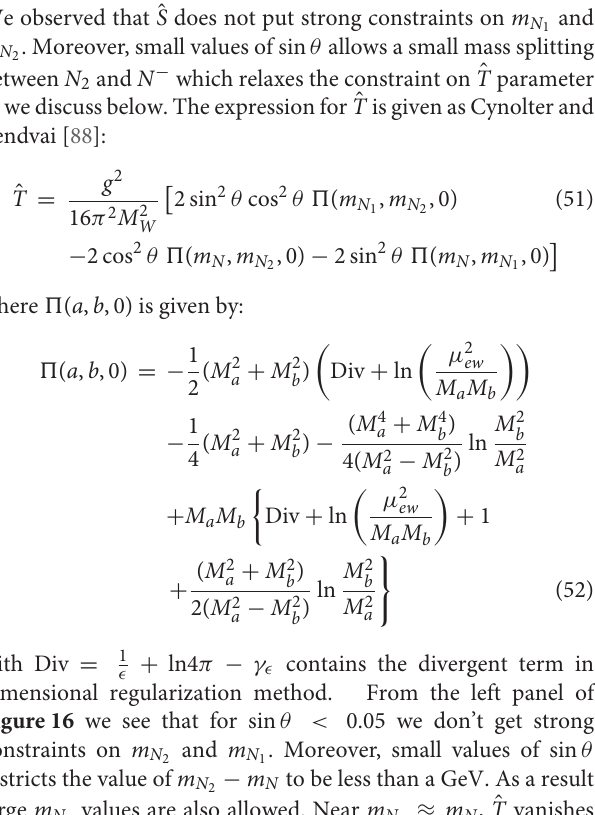
TABLE 3 | Global fit for the electroweak precision parameters taken from reference